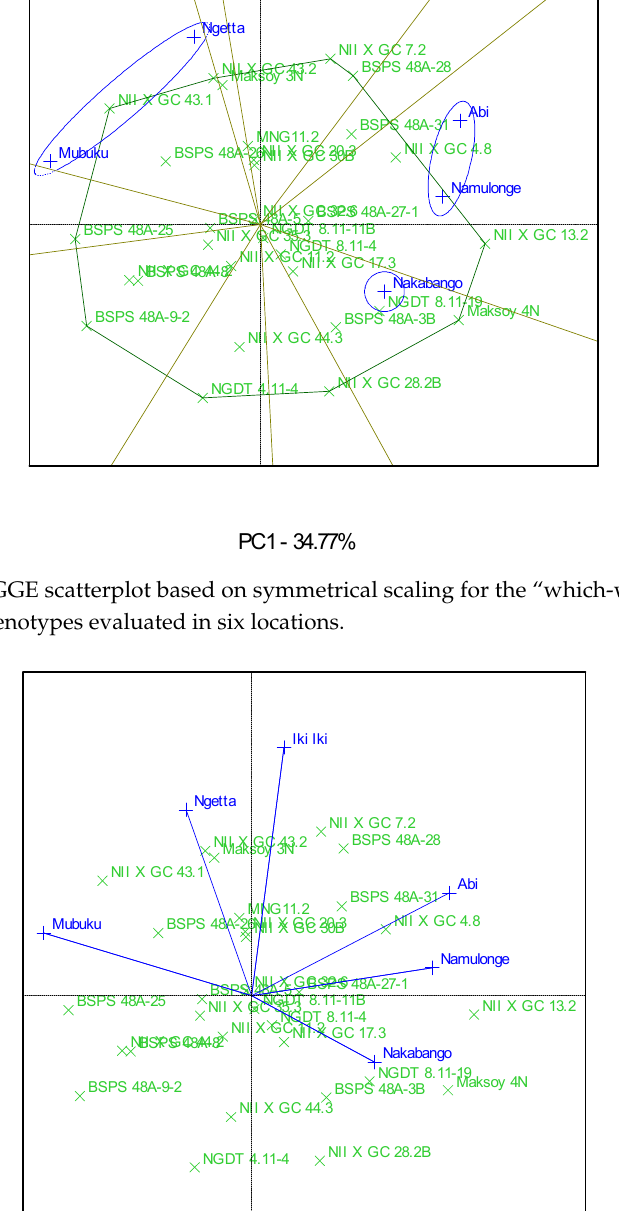
Figure 4. A GGE biplot showing the discriminating power and representativeness of test environ- ments involving 30 soybean genotypes evaluated in eight locations and six seasons .